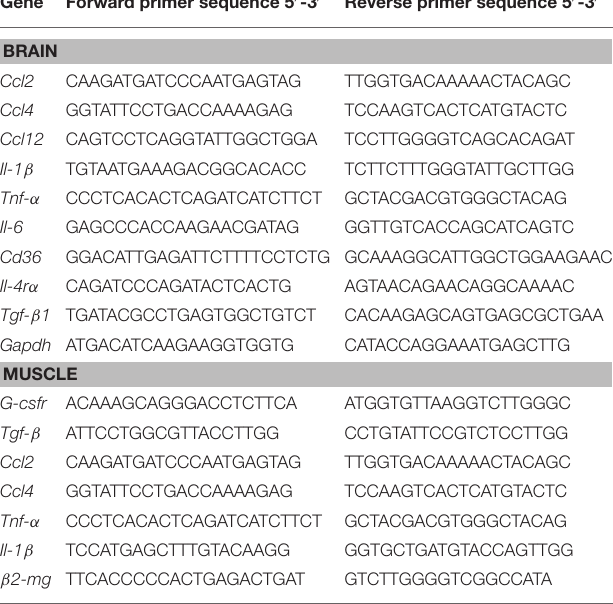
**different than SHAM and CTX; p < 0.05. See Results for additional